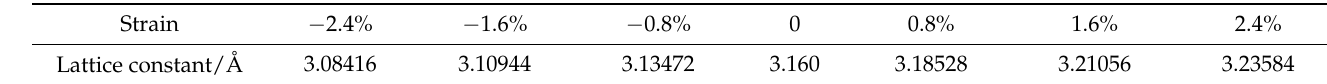
Table 1. Lattice constants at different strains.